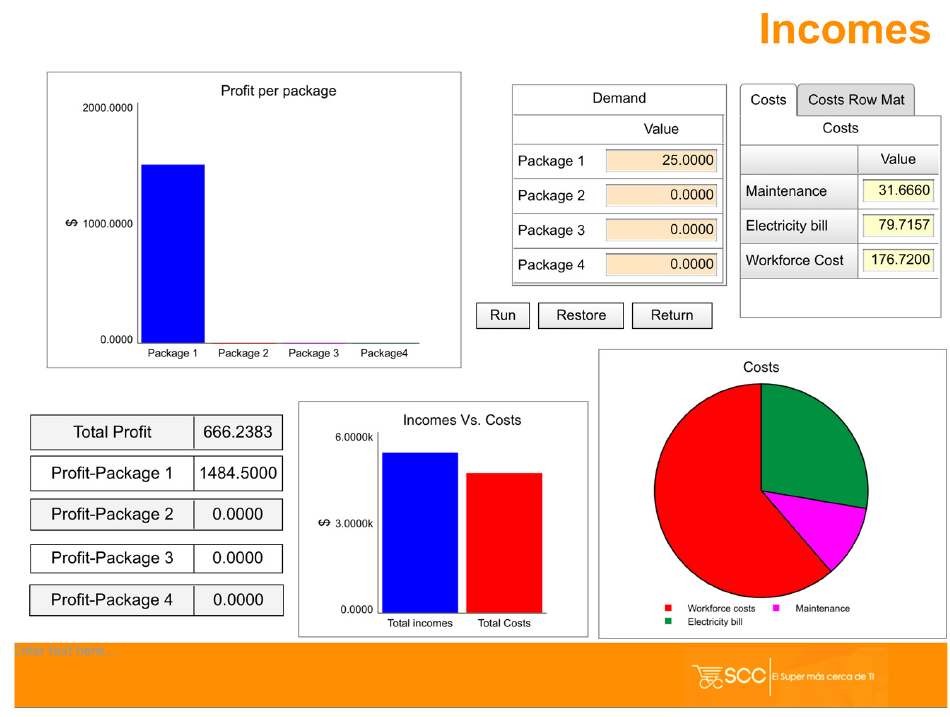
Figure 11. Graphical interface incomes.